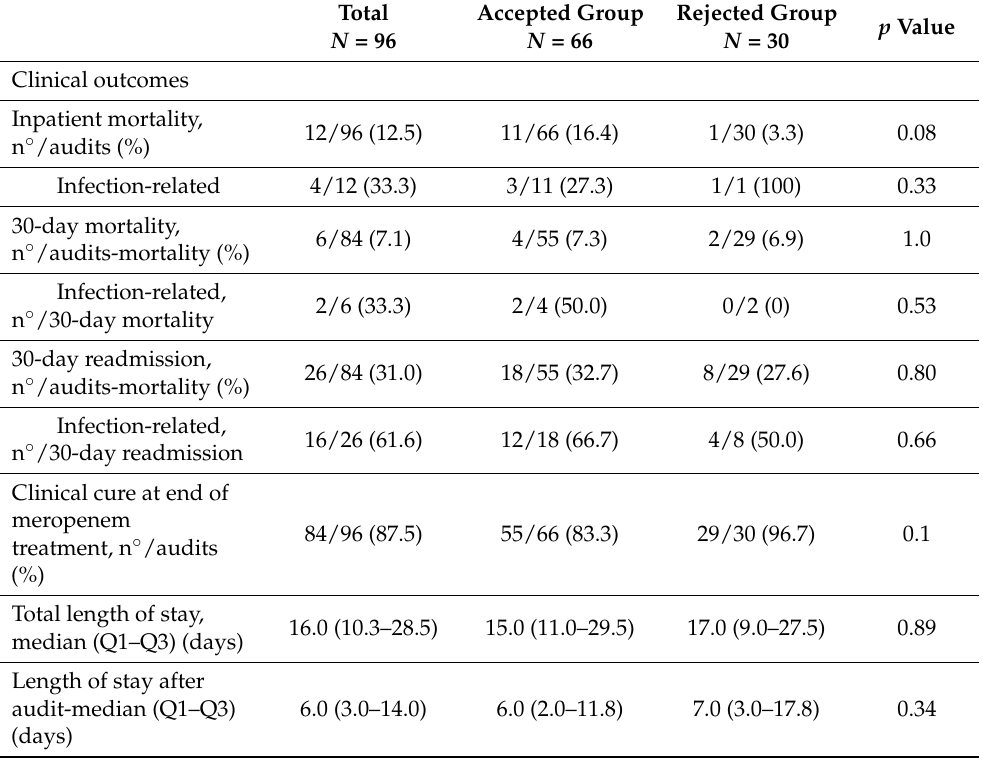
Table 4. Clinical, consumption and economic